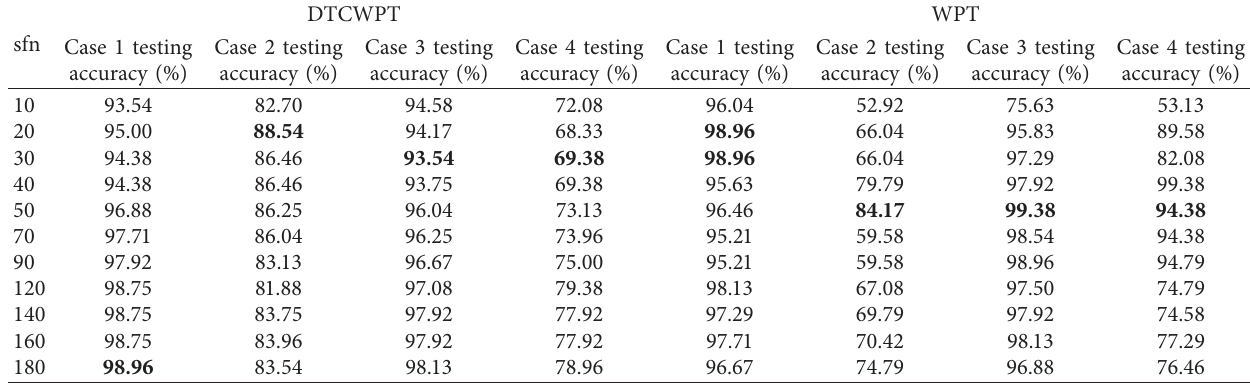
Table 11: Testing accuracies obtained by OFS-TSFRS-SVM.